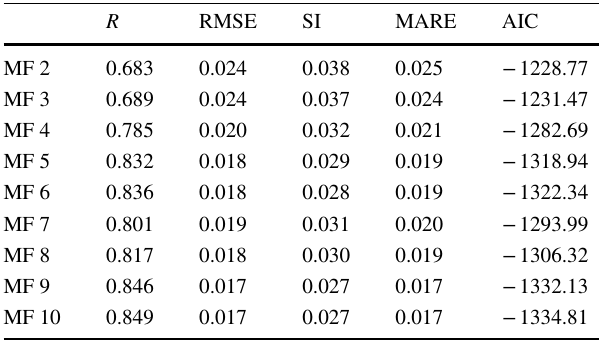
Table 2 Results of different statistical indices for ANFIS model membership